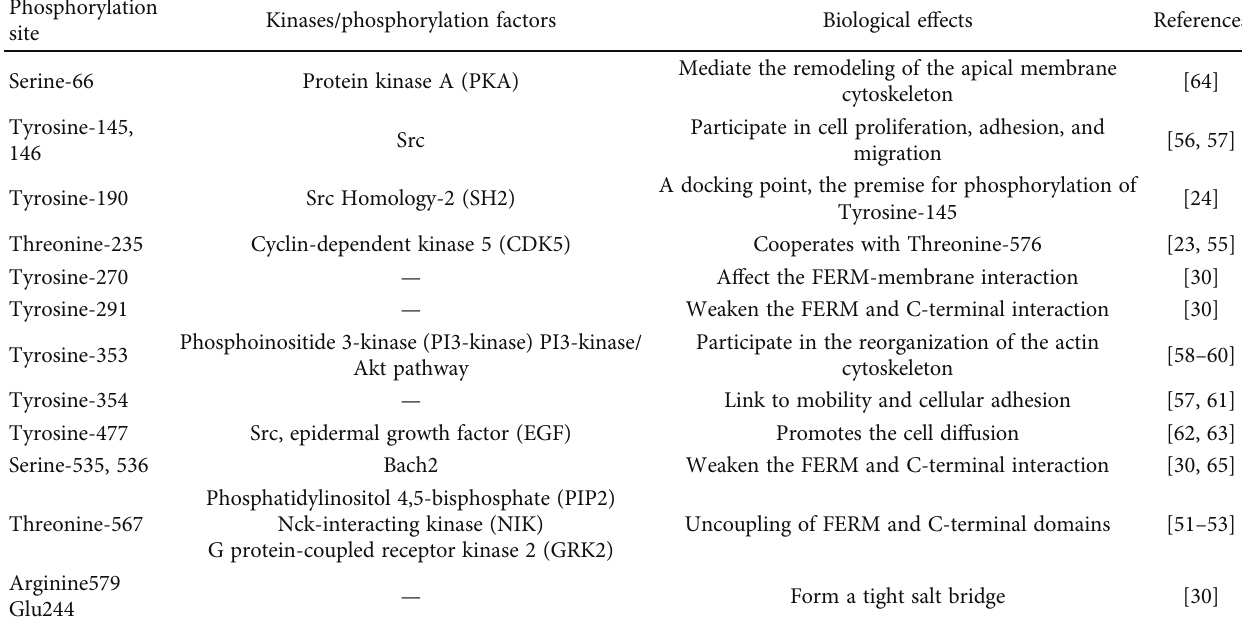
Table 1: Posttranslational modi fi cations of ezrin